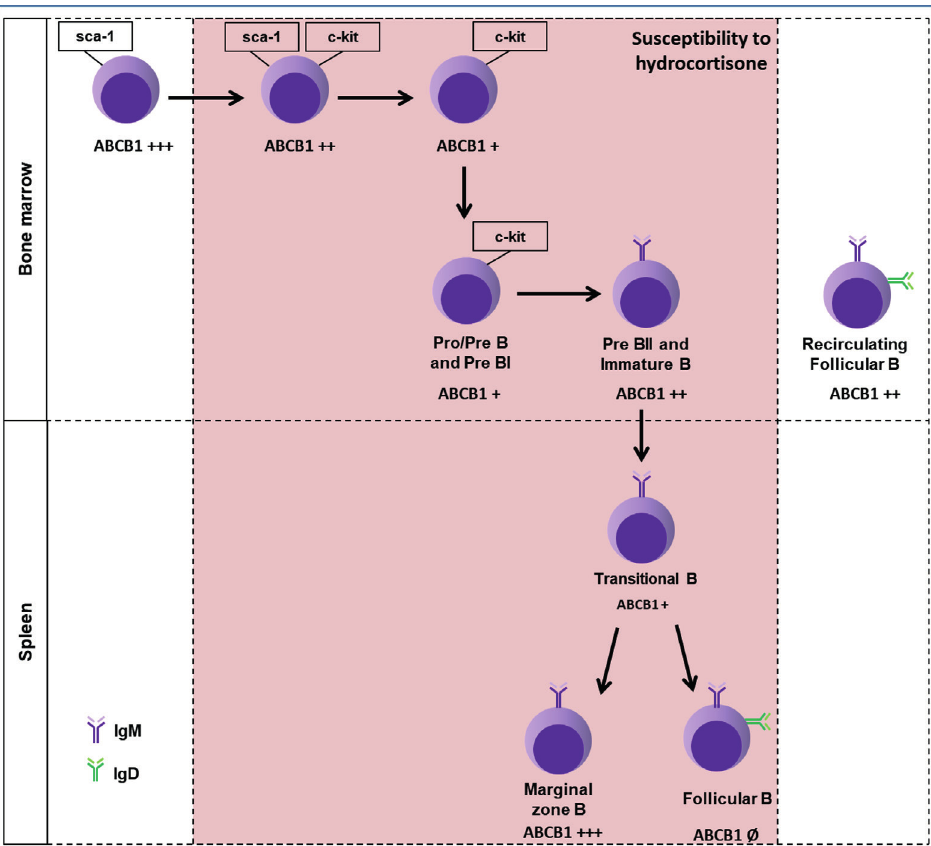
Figure 8 - Effect of in vivo consecutive treatment with hydrocortisone on ABCB1 activity of B cell subsets. The illustration shows B cell subsets sensitive and resistant to treatment with 3 consecutive i.p. injections (70, 140 and 200 mg/kg/day) hydrocortisone in C57BL/6 mice and reversion index of the ABCB1 transport ( Δ ) evaluated by rhodamine 123 efflux assay in the presence of the cyclosporin A inhibitor. Symbols as (Ø) represents no ABCB1 activity; (+), Δ < 2.0; (++), 2.0 ≤ Δ < 4.0; (+++), Δ ≤